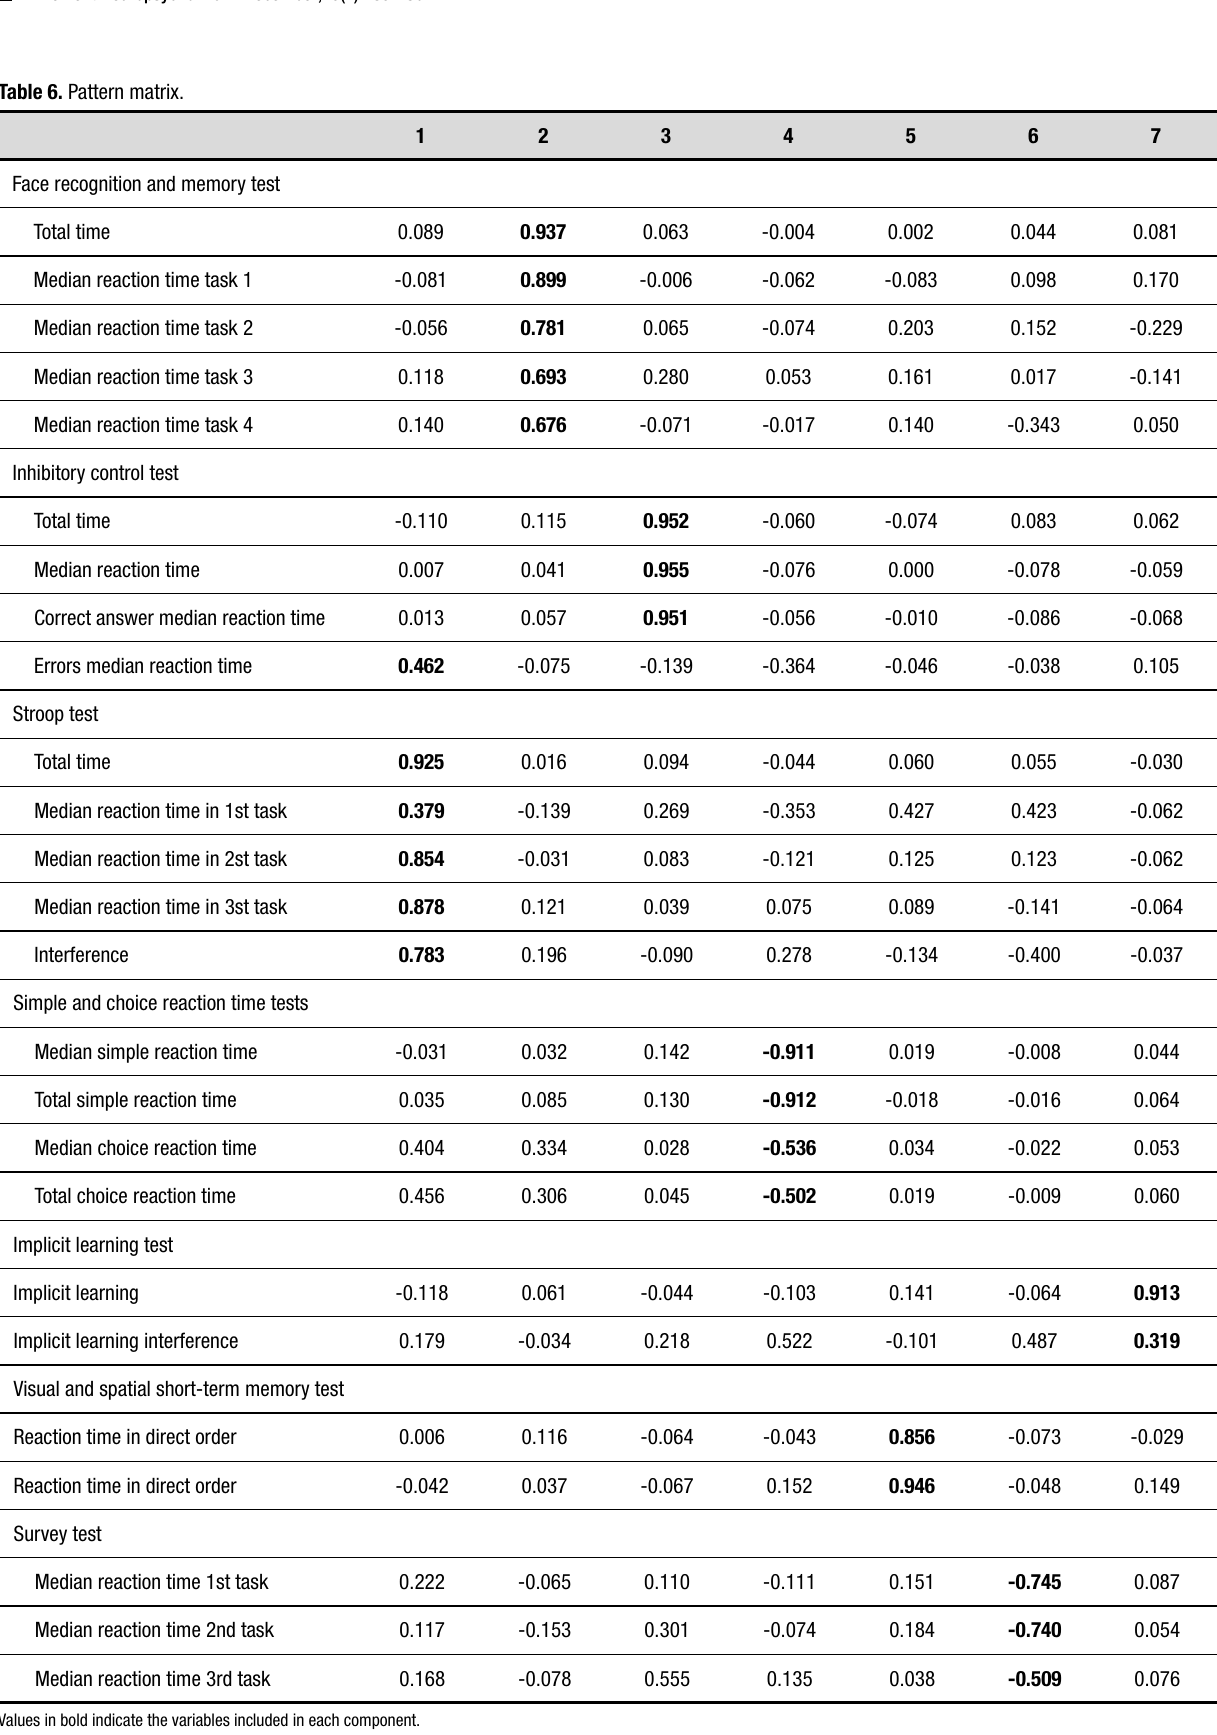
Values in bold indicate the variables included in each